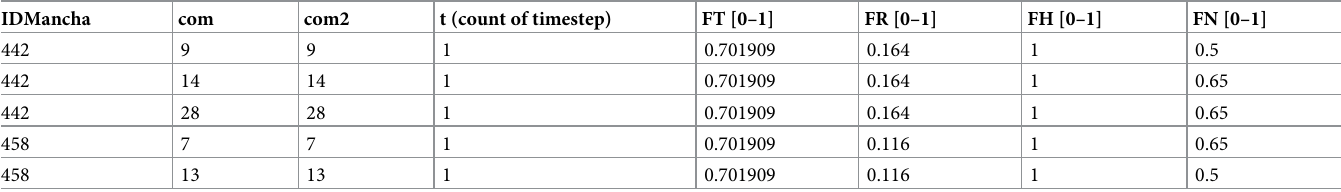
Table 3. Examples of parameters and values in the Puerto model.